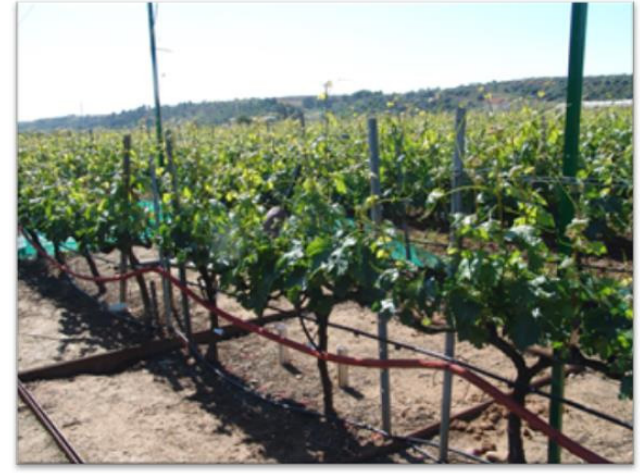
Figure 1. Surface view of the weighing lysimeter used in the study.